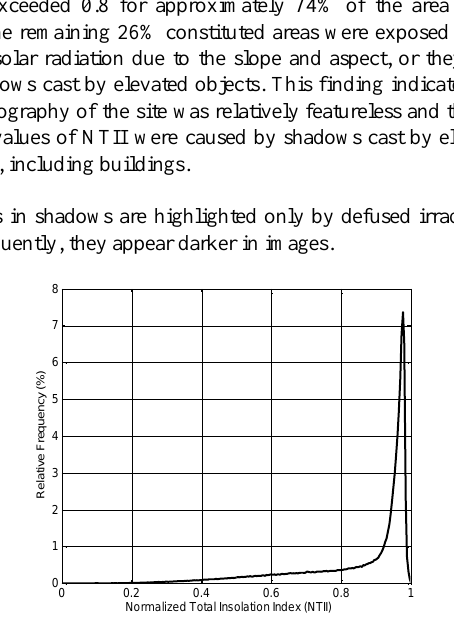
Figure 2. Histogram of the NTII for the AOI To assess the impact of cloud shadows on the pixel reflectance across spectral bands, the mean pixel intensities of both the in- shadow and no-shadow pixels were calculated for each spectral band. Figure 3 shows the ratio between the in-shadow and no- shadow pixel intensities vs. the wavelength.